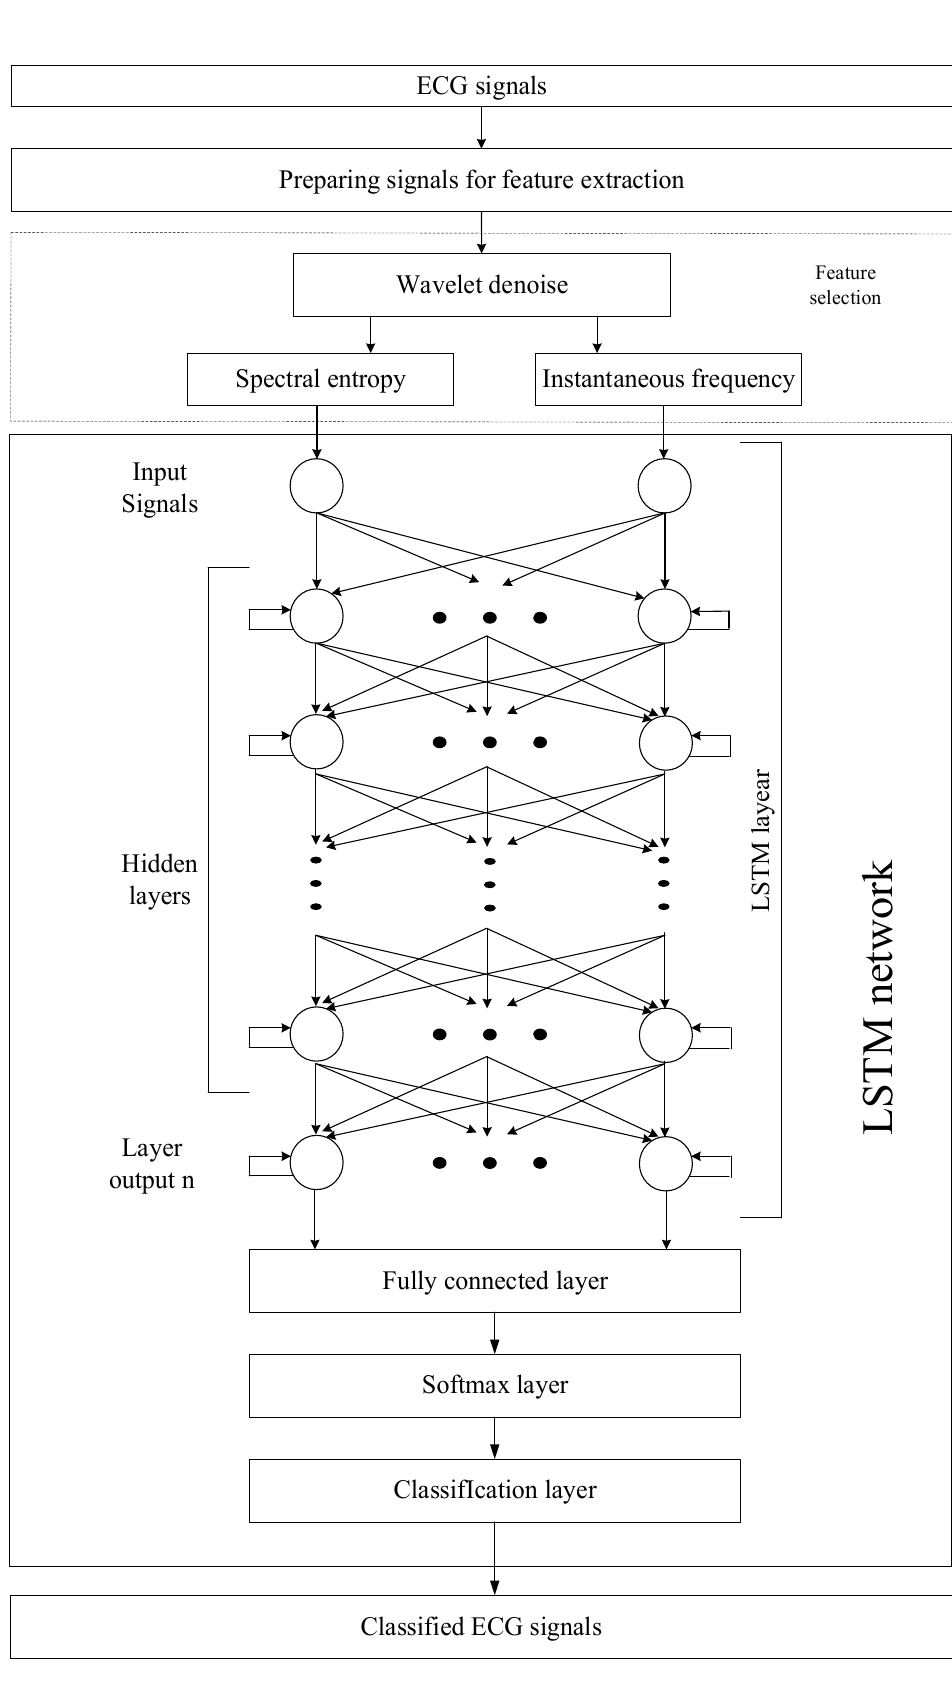
Figure 2. Neural network classification system with the pre-processing stage for ECG signals.